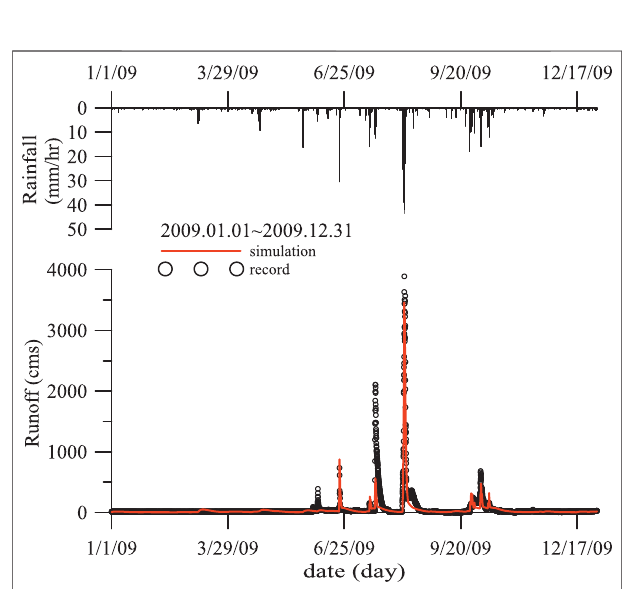
FIGURE 13 | Calibrated river runoff volume fl ow rate of the SiangYang catchment for 2009. The volume fl ow rate data were recorded by the Hsin- Wu-Lu river fl ow station of the Beinan River.